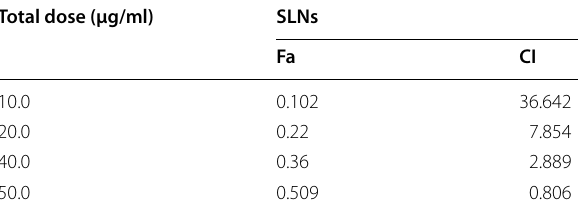
Table 8 CI values of SLNs